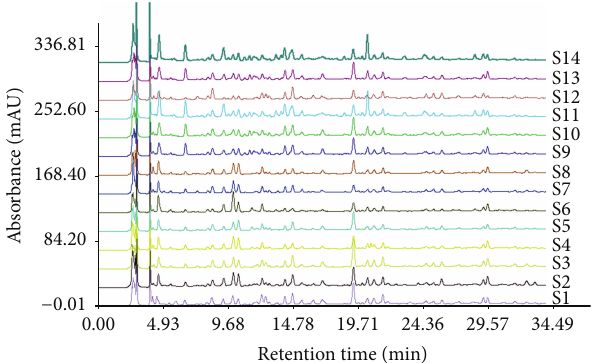
Figure 2: HPLC chromatograms from 14 batches of Benincasa hispida